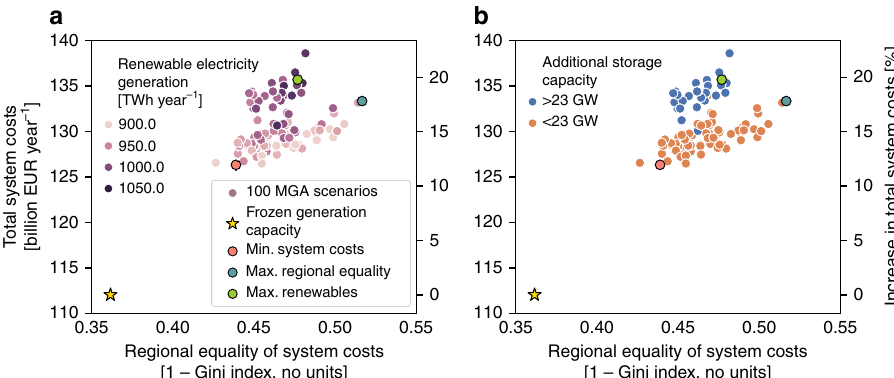
Fig. 5 Trade-off between total system costs and regional equality in 2035. Values show total system costs and regional equality of system costs per capita for the scenario of frozen generation capacity and 100 modeling to generate alternatives (MGA) scenarios. Amongst the 100 MGA scenarios, we highlight the scenarios of minimum system costs, maximum regional equality of system costs, and maximum renewable electricity generation. Percentage values on the second y -axis are relative to the scenario of frozen generation capacity. a Colors represent the trade-off with the extent of renewable electricity generation. b Colors represent the trade-off with additionally required storage capacity, where the cut-off value of 23 GW additional capacity was selected for visual purposes. MGA scenarios are generated with a slack of 20% above total levelized electricity generation costs of the cost-optimal solution in EXPANSE and assuming that each country meets its national electricity generation targets for 2035 (see “ Methods ” ). Source data are provided in Supplementary Data